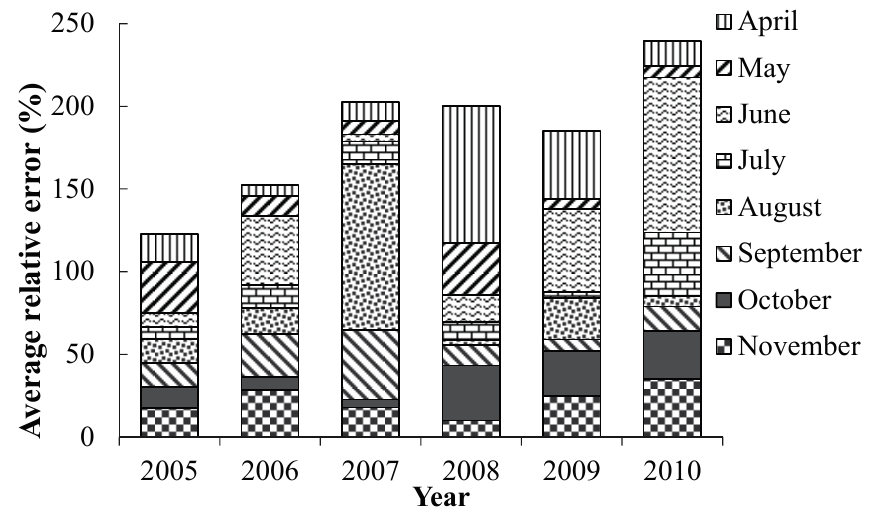
Figure 8. Average relative errors for each month.